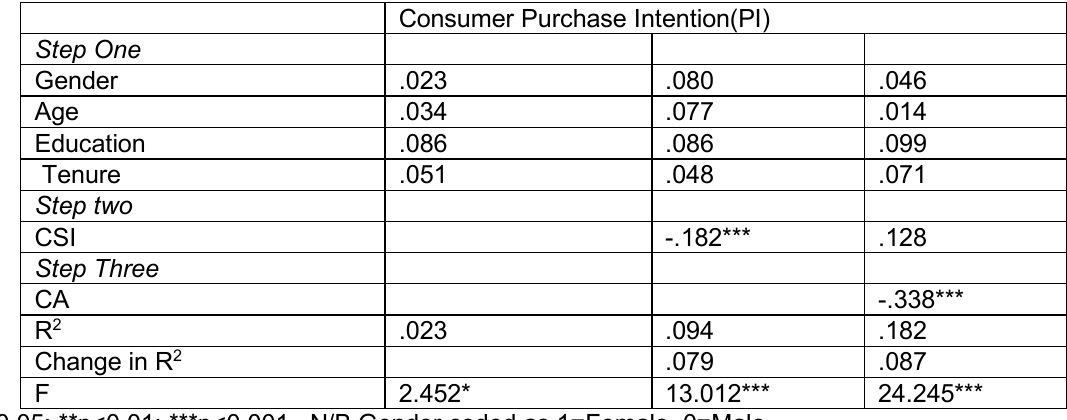
Table 6: Mediation effect of CA in the relationship between CSI and